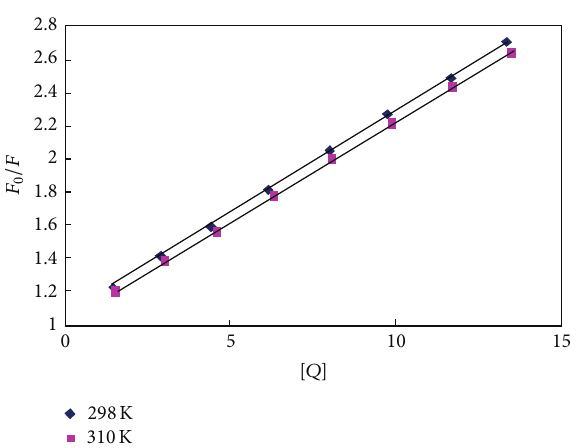
Figure 3: Effect of warfarin on fluorescence spectrum of HSA; form curve 1 → 9 , 𝐶 ( 0, 2,4, 6, 8, 10, 12, 14,16 × 10 −6 M, respectively.